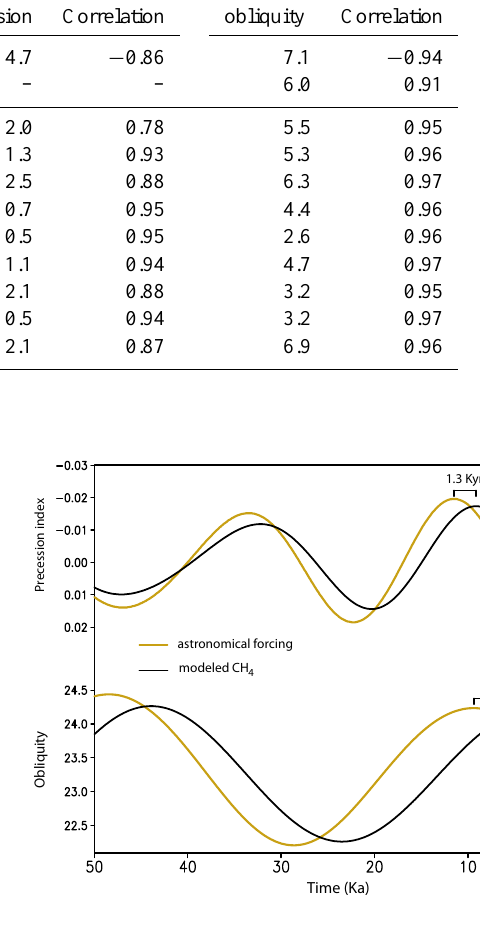
Fig. 8. (top) TRENCH simulated global CH 4 emissions, band pass filtered for 21Kyr ( ± 2.5kyr) and the precession index, and (bot- tom) TRENCH simulated global CH 4 emissions, band pass filtered at 41k ( ± 3Kyr), and the obliquity parameter. Lags between forcing and response are indicated for each